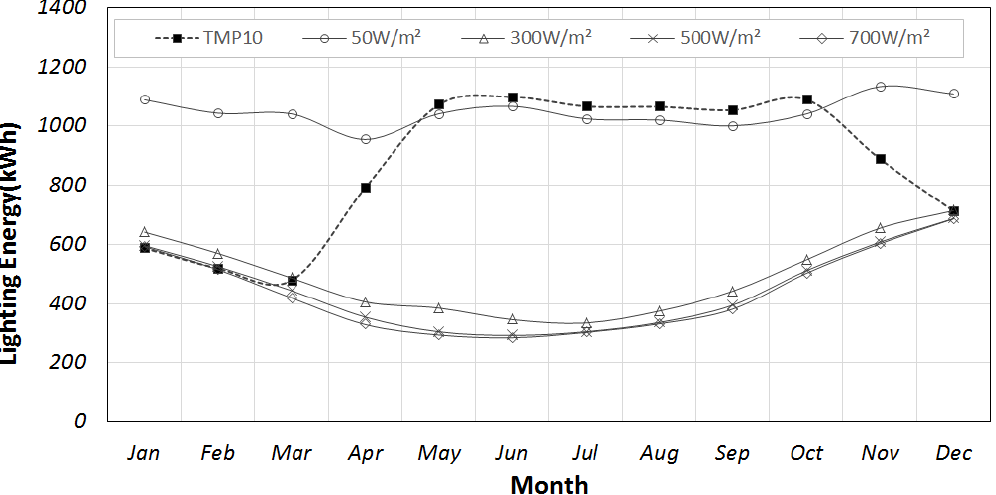
Figure 14. Monthly lighting energy consumption by electrochromic glass’ controlling conditions.